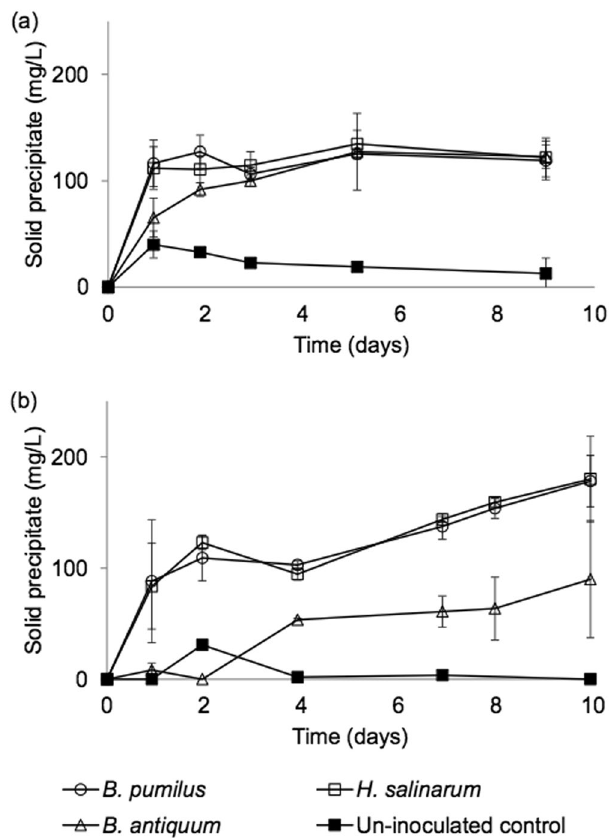
Figure 5. Solid precipitate production when incubating the selected bacteria in: ( a ) pH controlled through acid addition (Experiment A) and ( b ) pH controlled by limiting degassing in closed serum bottles (Experiment B). Controls were not inoculated with bacteria. Error bars represent standard deviation obtained from triplicate tests.